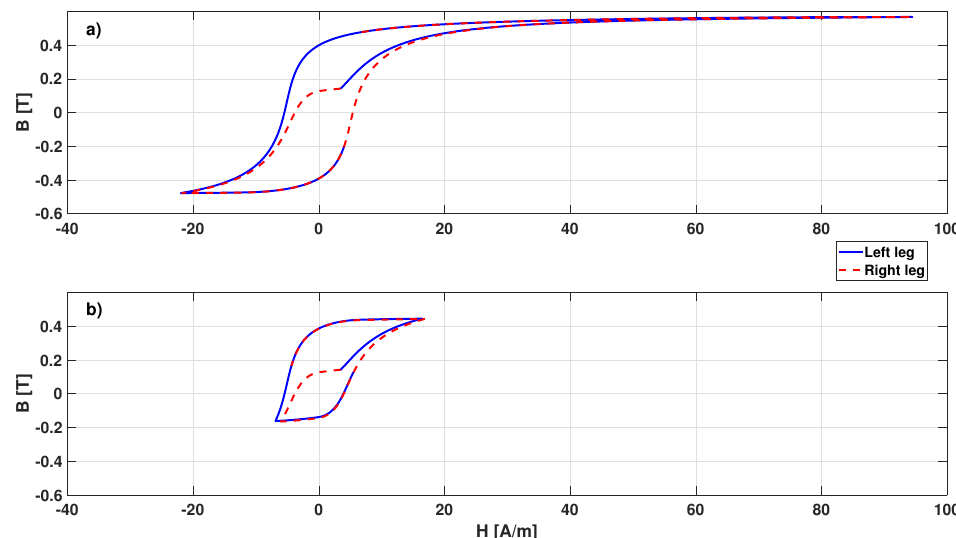
Figure 20. Hysteresis loop covered in one excitation period by the left (solid blue lines) and right (dashed red lines) core legs with the closed core configuration ( a ) and with a 0.5 mm air gap ( b ), when an external field of 100 µ T is applied, and the JA2 hysteresis model parameters are